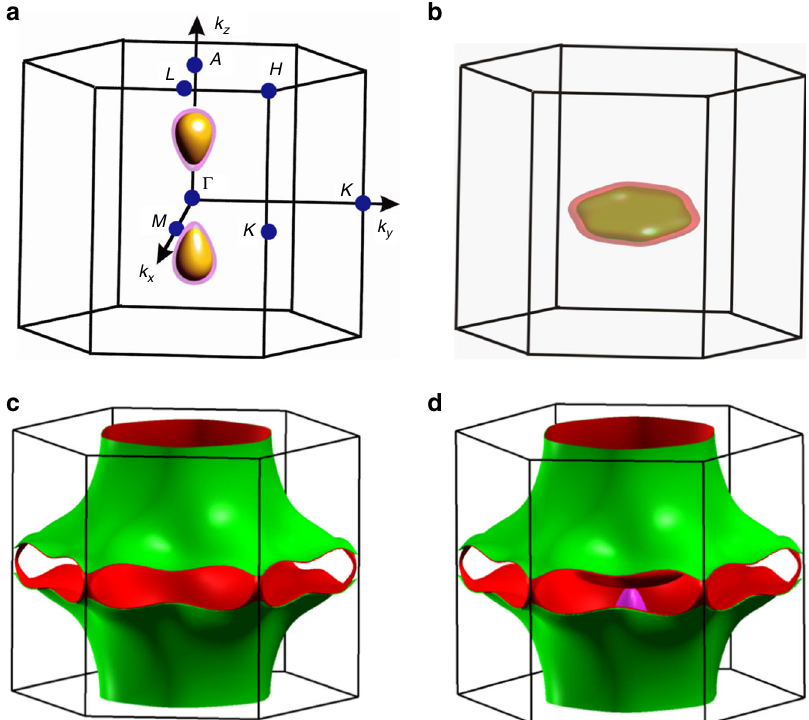
Fig. 3 Shape of the Fermi surfaces (FSs) in the fi rst Brillouin zone (BZ) of MoP. a Small droplet-type electron pockets which contribute negligibly to the charge-carrier density. b Flat hole pockets at the center of the BZ. c Open FSs that extend over the entire BZ. d Electron pockets, hole pockets, and open FSs combined together in the BZ. Due to the non-centrosymmetric structure of MoP, the pockets as well as the open FSs are spin-split and appear in